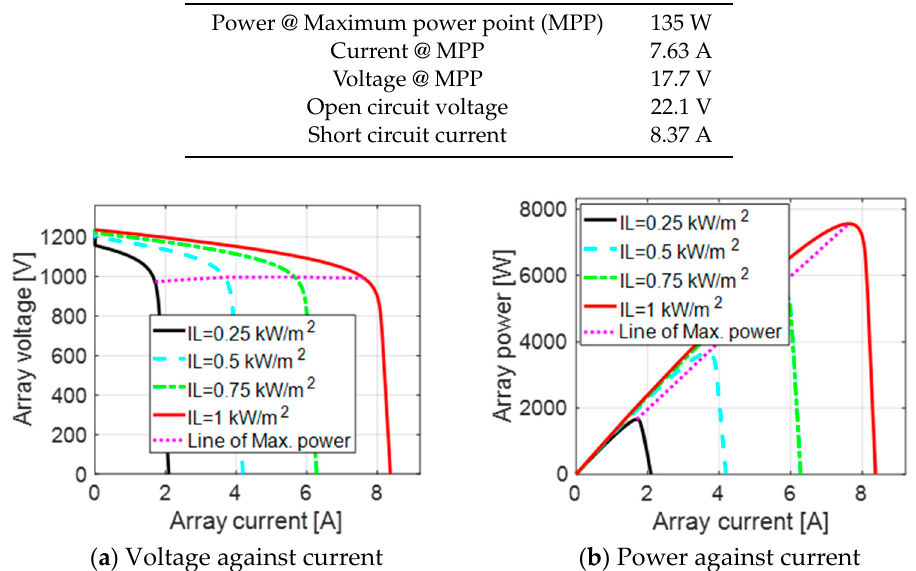
Table 2. Characteristics of the solar module (KD135SX-UPU).